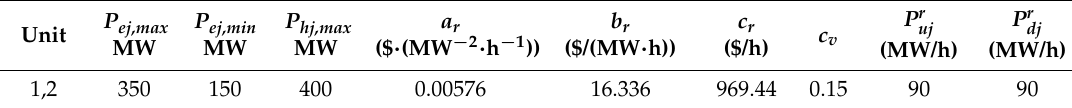
Table 2. The parameters of cogeneration units. 336